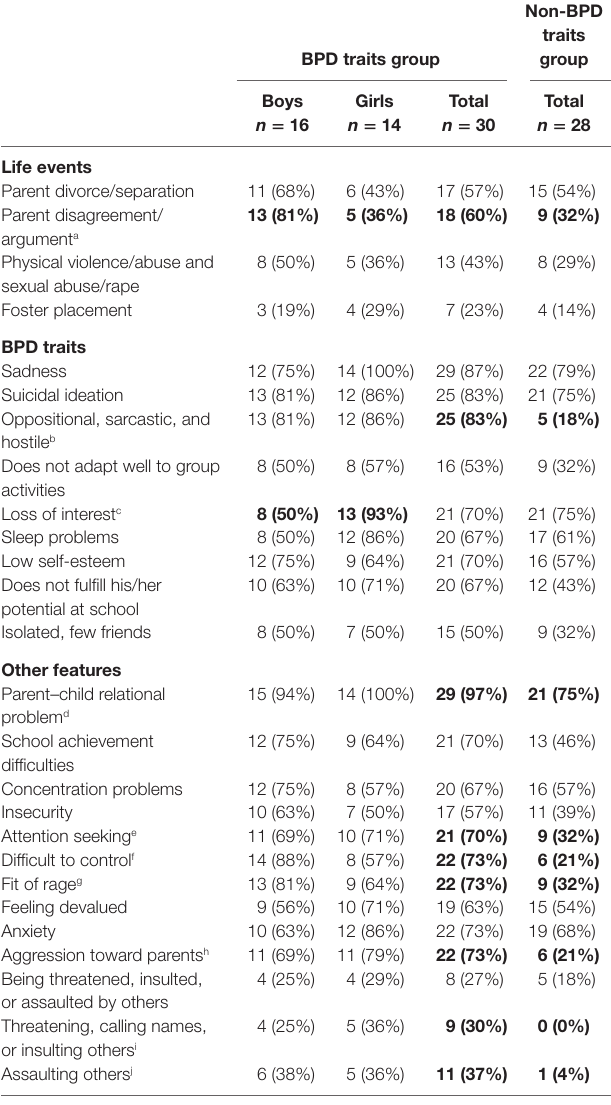
TaBle 3 | Most frequent life events and clinical symptoms according to gender and diagnosis.